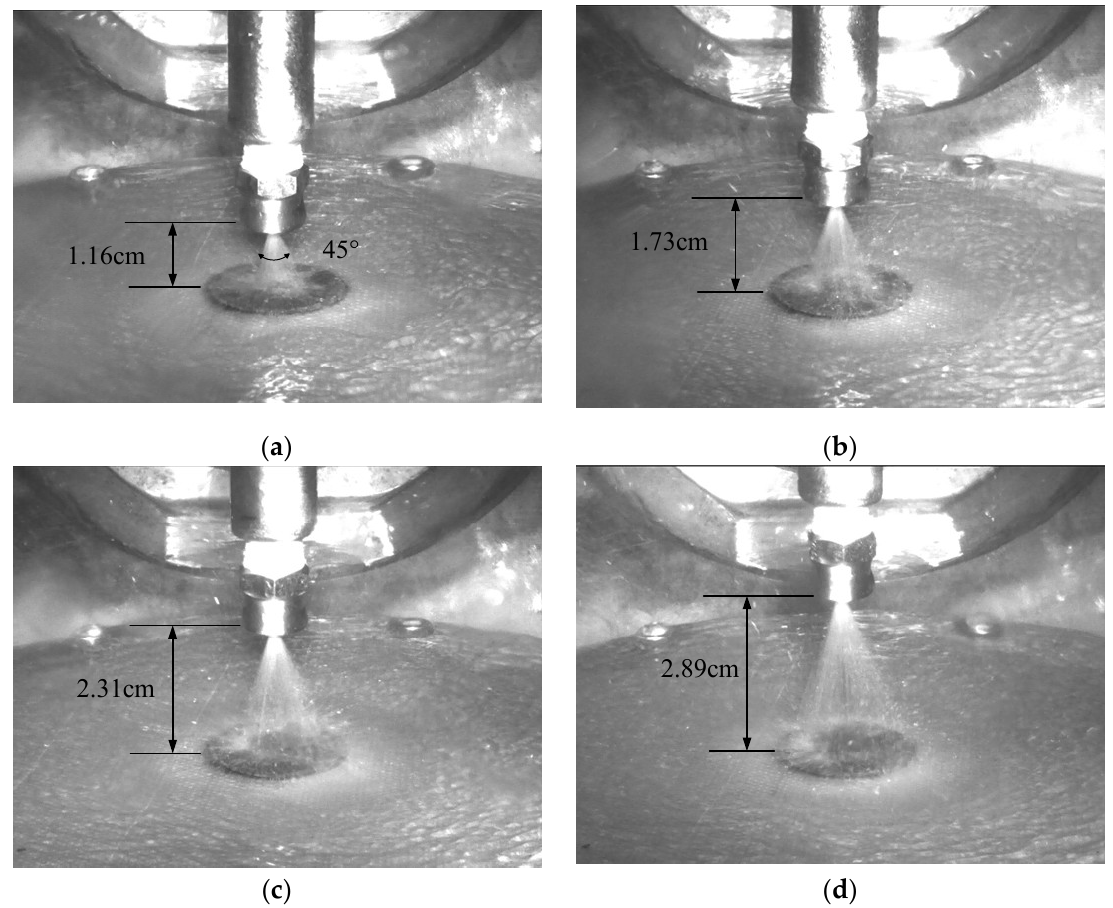
Figure 13. Visualization images of the effect of nozzle height change on spray coverage at a flow rate of 40 L/h: ( a ) height 1.16 cm, coverage16%; ( b ) height 1.73 cm, coverage 36%; ( c ) height 2.31 cm, coverage 64%; ( d ) height 2.89 cm, coverage 100%.